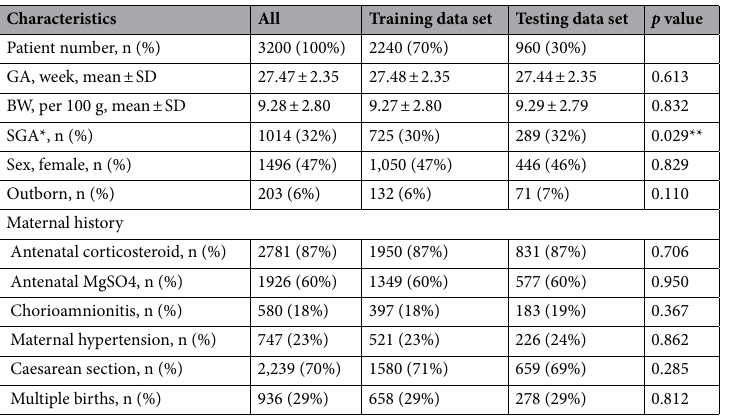
Table 2. Patient characteristics. BW Birth weight; GA Gestational age; SD Standard deviation; SGA Small for gestational age. *Reference: Hsieh 21 . ** p <